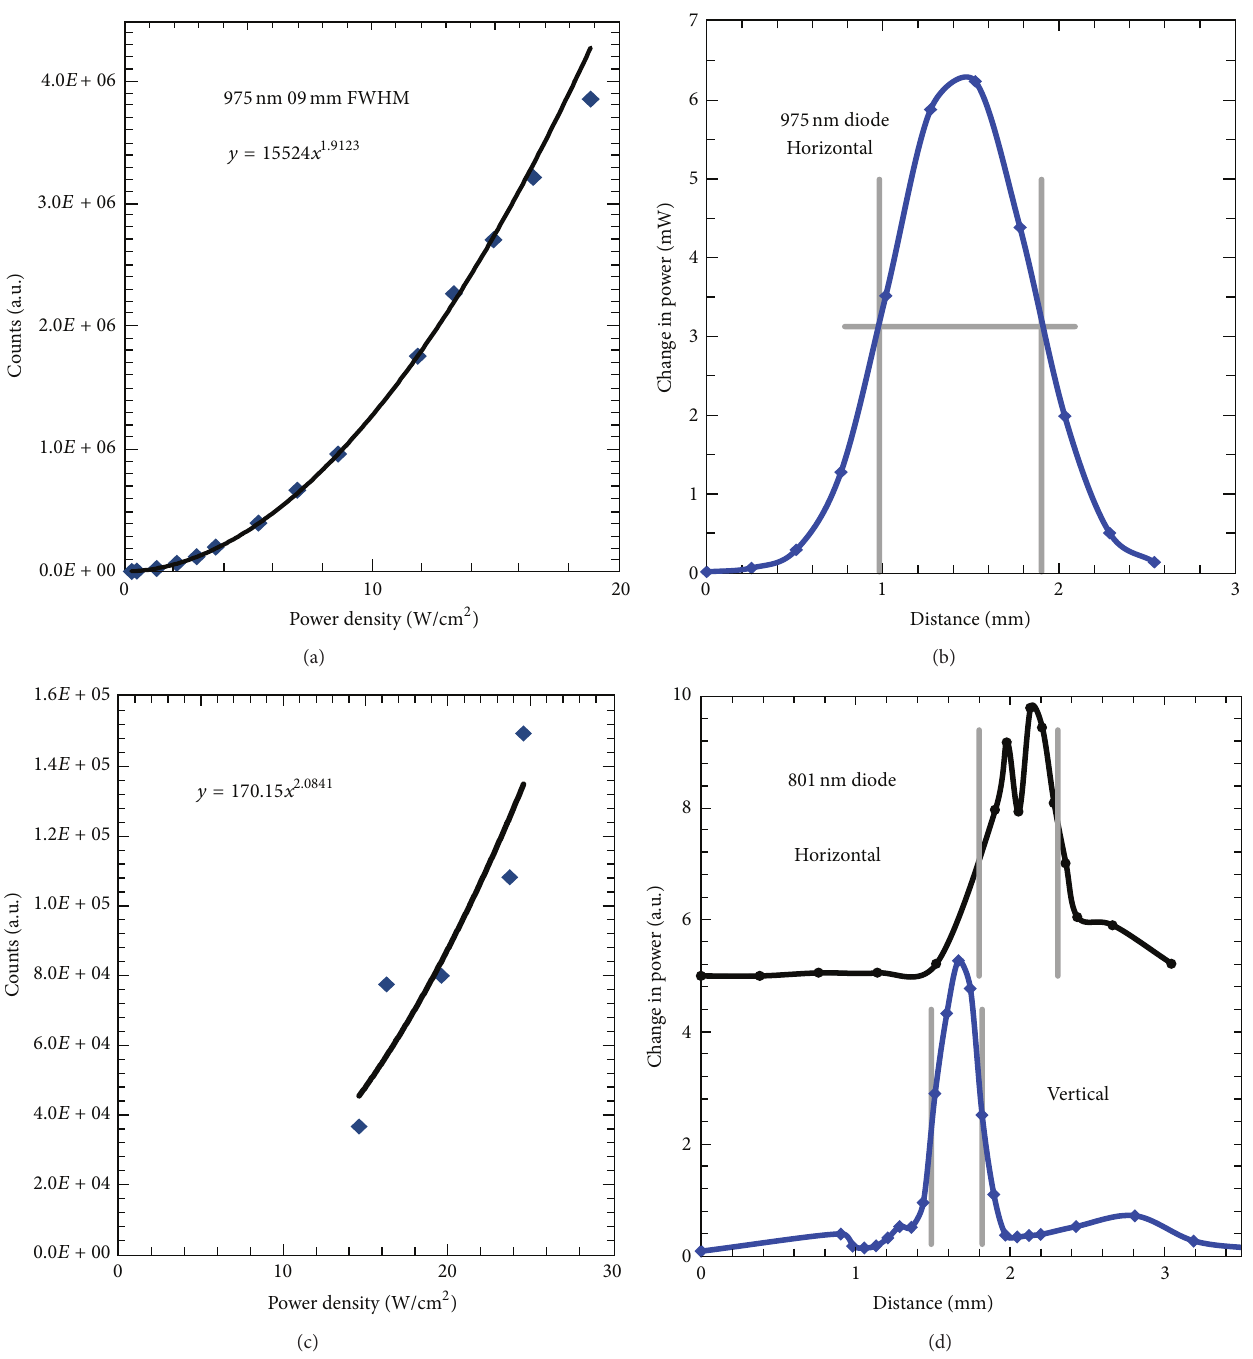
Figure 9: Power dependence of direct atomically excited upconversion of NaYF 4 :Yb 3+ , Ho 3+ excited at 975 nm (a). Beam size measurement of the fiber-coupled 975 nm diode laser (b). Power dependence of direct atomically excited upconversion of NaY 0.85 Er 0.15 F 4 excited at 801nm (c). Beam size measurements for the vertical and horizontal directions for the 801nm free-space diode laser (d).